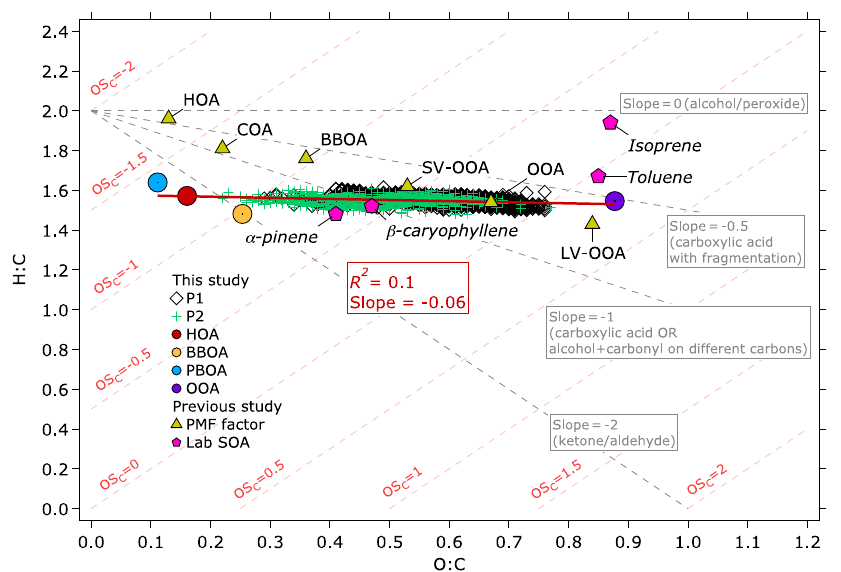
Figure 8. Van Krevelen diagram of the OA measured during the 2015 haze episode and the OA factors resolved by the ME-2 analysis. The H : C to O : C ratios are colored based on the P1 and P2 periods. The H : C to O : C ratios of the OA factors resolved by the ME-2 analysis of this study are plotted as colored circles. Linear regression analysis of H : C vs. O : C from the OA factors yielded R 2 = 0 . 1 and slope = − 0 . 06 as plotted on the figure. Comparison with HOA, BBOA, cooking OA (COA), OOA, semi-volatile OOA (SV-OOA), and low-volatility OOA (LV-OOA, triangle markers) and laboratory-generated SOA (hexagonal markers) of previous studies (Canagaratna et al., 2015, and references therein) show that the OOA factor of this study exhibits close characteristics to LV-OOA and toluene-derived SOA, indicating that its formation could be attributed to atmospheric